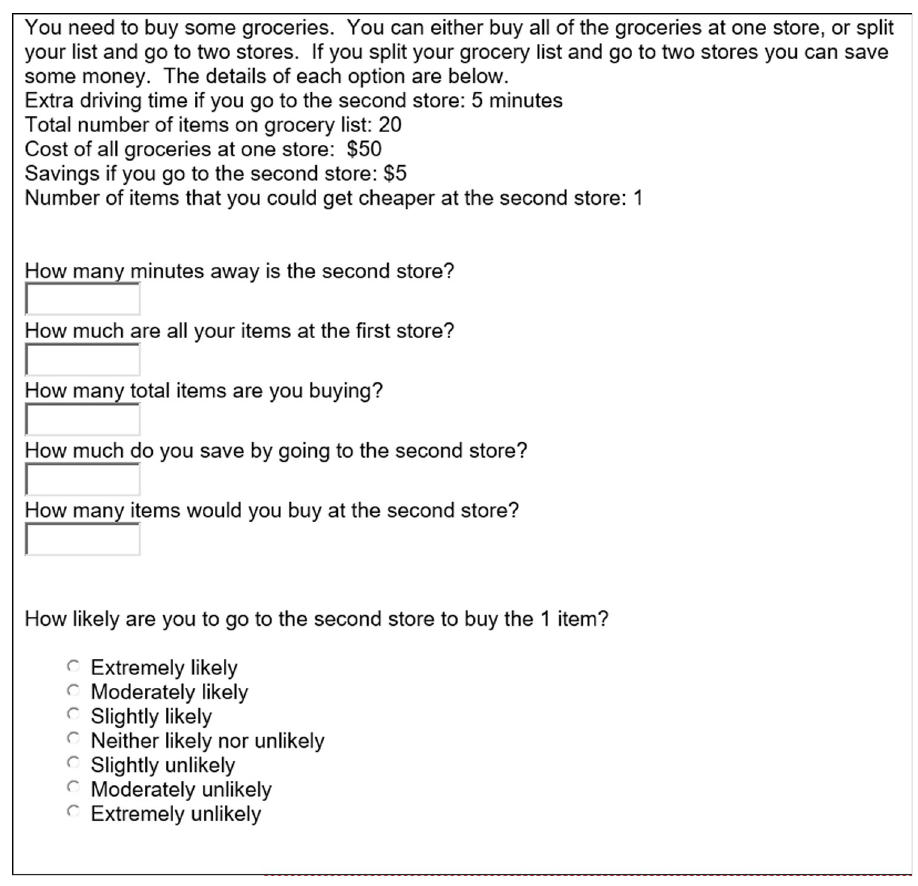
Fig 4. Example study 2